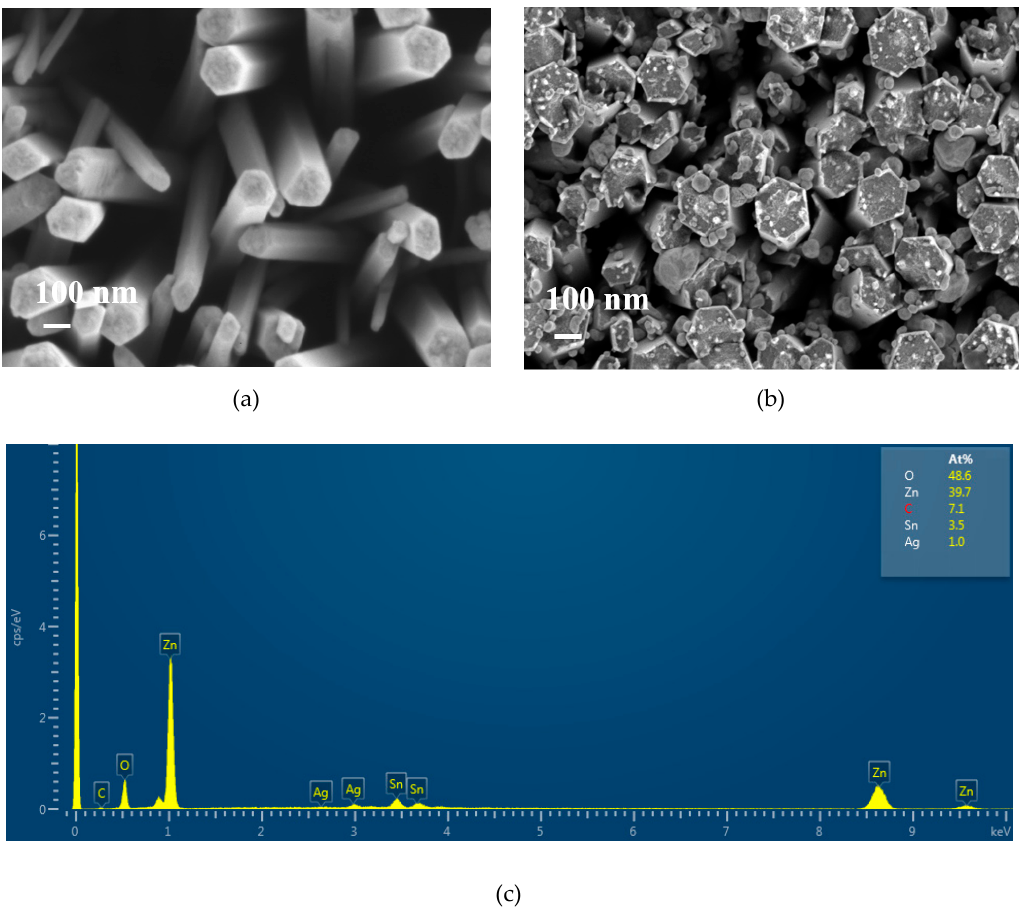
Figure 3. SEM analysis of ( a ) ZnO-Ag, ( b ) ZnO:N-Ag NRs, and ( c ) Elemental EDS spectrum of ZnO-Ag sample.